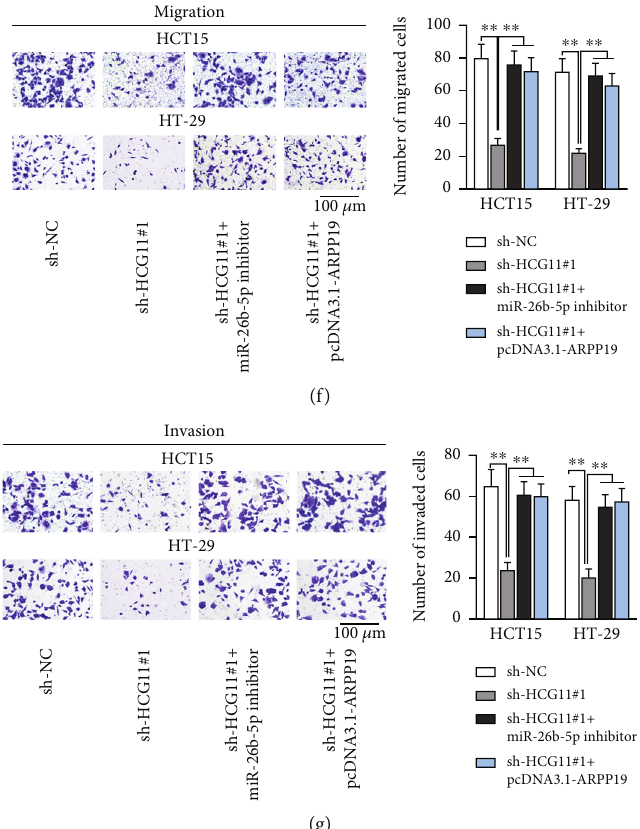
Figure 5: HCG11 exacerbates CRC cell malignant behaviors through modulating the miR-26b-5p/ARPP19 axis. (a) The overexpression e ffi ciency of pcDNA3.1-ARPP19 was assessed through qRT-PCR. HCT15 and HT-29 cells transfected with sh-NC, sh-HCG11#1, sh- HCG11#1+miR-26b-5p, or sh-HCG11#1+pcDNA3.1-ARPP19 were used for functional assays in a rescue manner. (b, c) CRC cell proliferation was evaluated by EdU assay and colony formation assay. (d, e) The cell apoptosis ability was measured via TUNEL assay and JC-1 assay. (f, g) The cell migration and invasion abilities were detected via transwell assay. ∗∗ p < 0 : 01